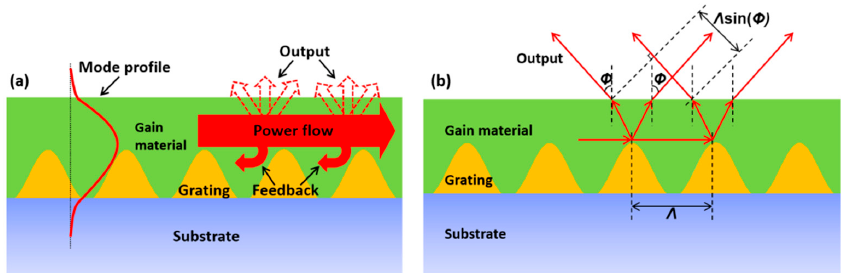
( b ) Optical path analysis for interference output rays of a high-order distributed-feedback (DFB)